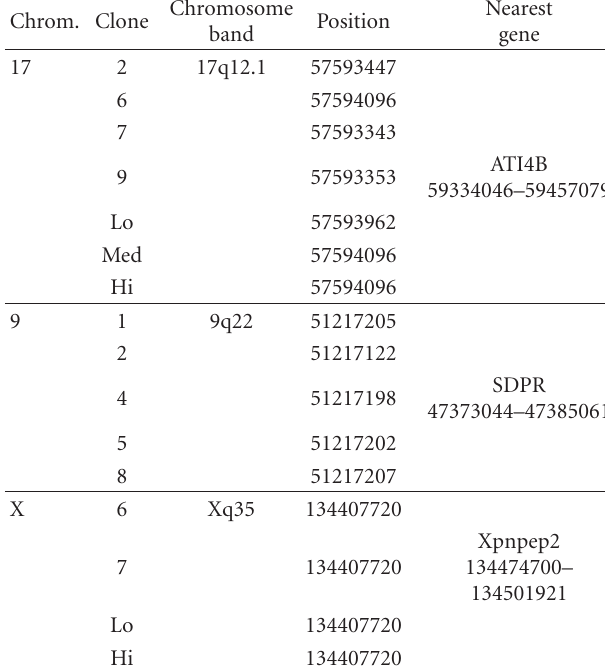
Table 4: Hotspots for φ C31-mediated integration in the genome of rat MAPC. Nine drug-resistant clones and an additional three clones picked on the basis of GFP expression were analyzed for integrant number and genomic location. Of all the integration sites identified, the location on chromosome 17 (17q12.1) was found to be targeted with highest frequency (7 out of 12 clones) followed by chromosome locations 9q22 (5 out of 12 clones) and Xq35 (4 out of 12 clones). Exact genomic location of the integrant and the nearest gene to the site of integration is listed for each chromosome hotspot. Chromosome Chrom. Clone